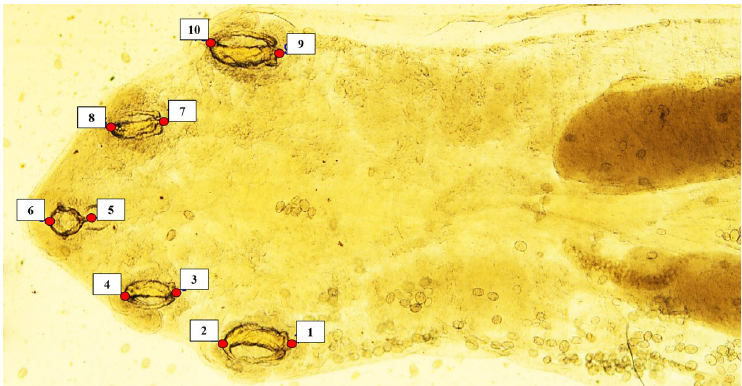
Fig 1. Whole mount of Raillietiella orientalis showing placement of homologous landmarks. Ten landmarks were used in geometric morphometric analyses to examine variation in hook and oral cadre morphology among host taxa. Pentastome samples were cleared in a phenol solution prior to analyses. The R . orientalis pentastome shown was collected from a snake, Nerodia clarkii , native to Florida.